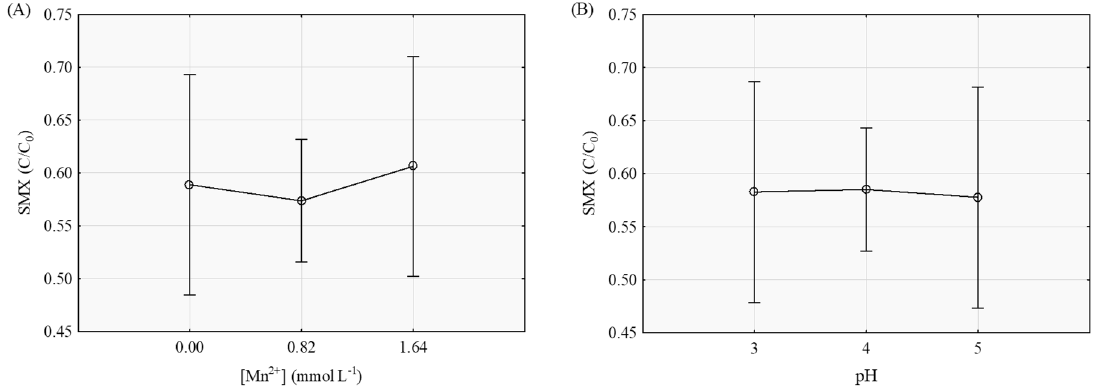
Figure 4. Graph of the global average of relative concentration of SMX in all the runs conducted, for the three levels tested of ( a ) Mn 2+ and ( b ) pH.